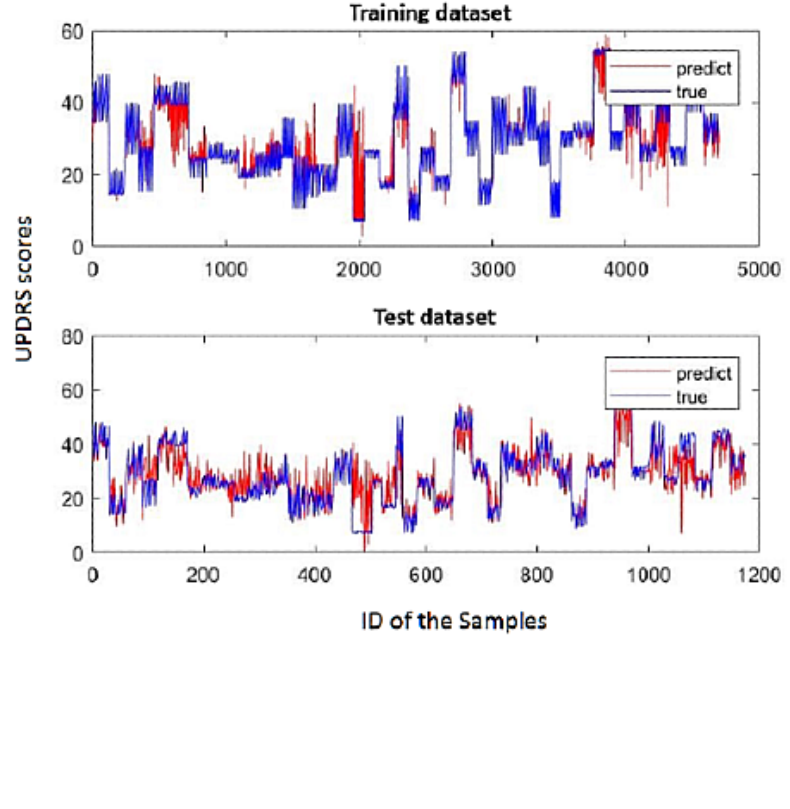
Figure 4. Support vector regression (SVR) fitting. The red line is the predicted value and the blue line is the true value. UPDRS: Unified Parkinson's Disease Rating